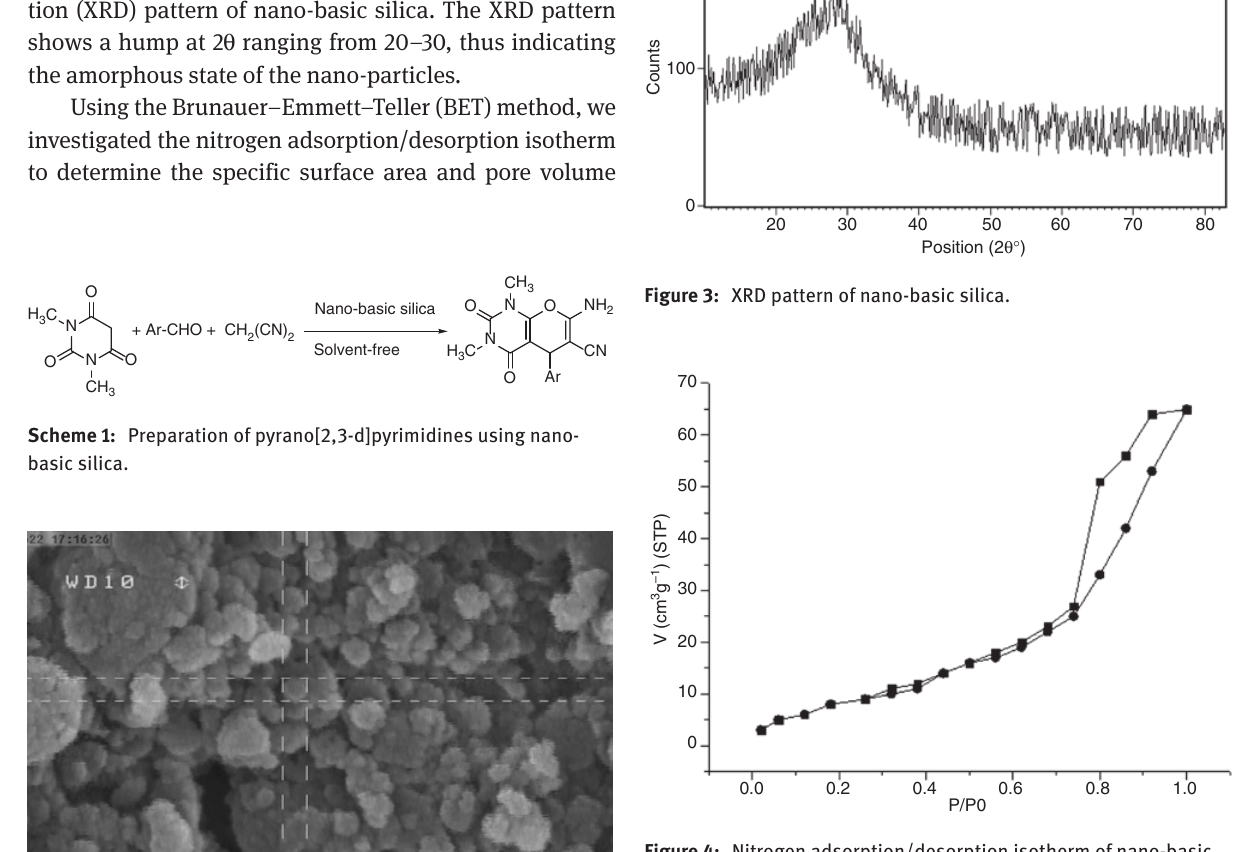
Figure 4: Nitrogen adsorption/desorption isotherm of nano-basic silica at